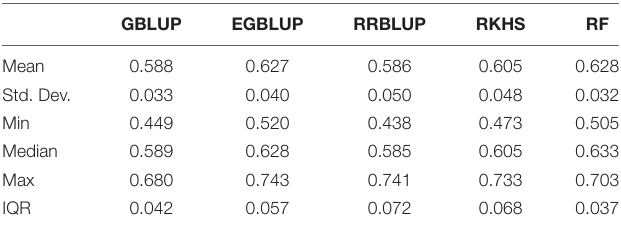
TABLE 2 | Prediction accuracies using five-fold cross-validation for different genomic prediction models for the G × E data of stripe rust disease score as E4. GBLUP EGBLUP RRBLUP RKHS RF